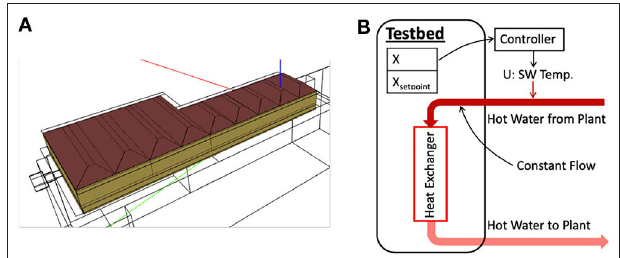
FIGURE 5 | Simulation testbed based on Intelligent Workspace. (A) Is a geometric view of the EnergyPlus model rendered by OpenStudio (Guglielmetti et al., 2011), and (B) Is a schematic of the water-based radiant heating system.